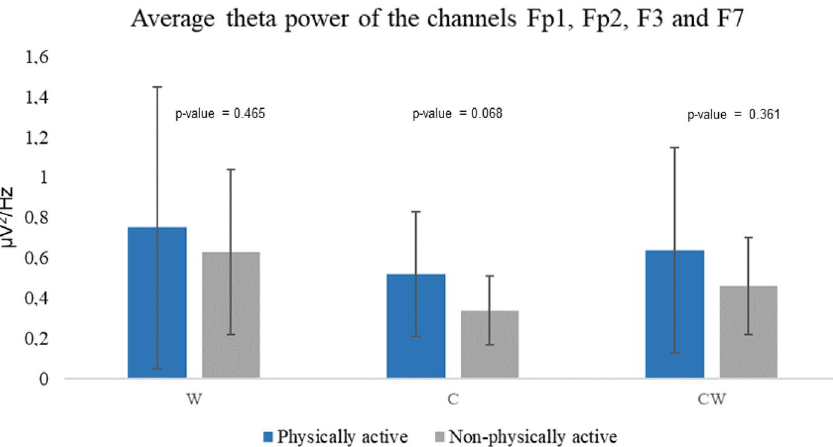
Figure 2. Average theta power spectrum (4–7 Hz) for Fp1, Fp2, F3 and F7 electrodes in physically and non- physically active women with FM. Differences were not found between or within groups. W names of colors printed in black, C names different color patches, CW names color-word, where color-word are printed in an incongruous color ink (name the color of the ink instead of reading the word).